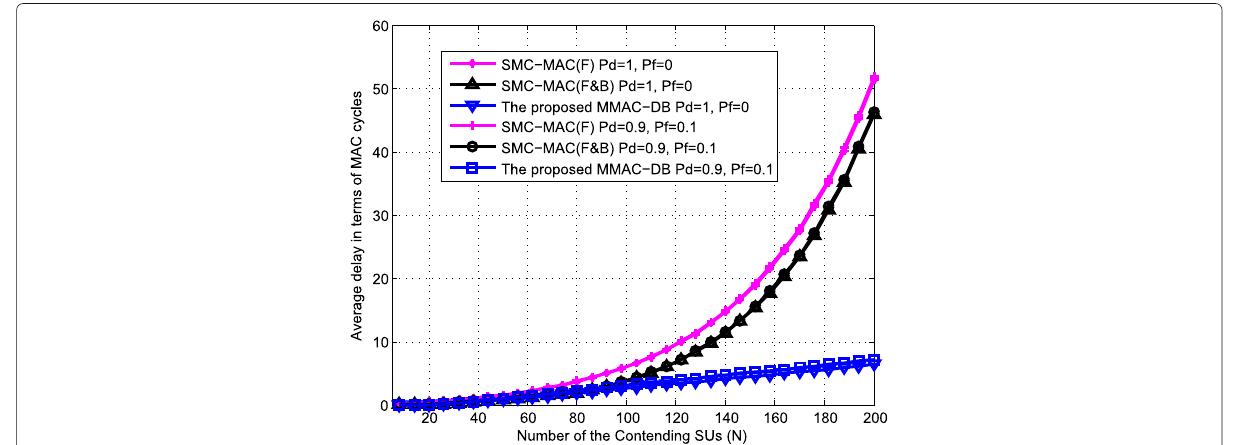
the channel access delay of the distributed cognitive radio network are enhanced compared with those of the two existing CR-MAC protocols, which is demonstrated by extensive simulations and the network throughput improvement is up to 282.75% under perfect sensing scenario and is up to 272.37% under imperfect sensing